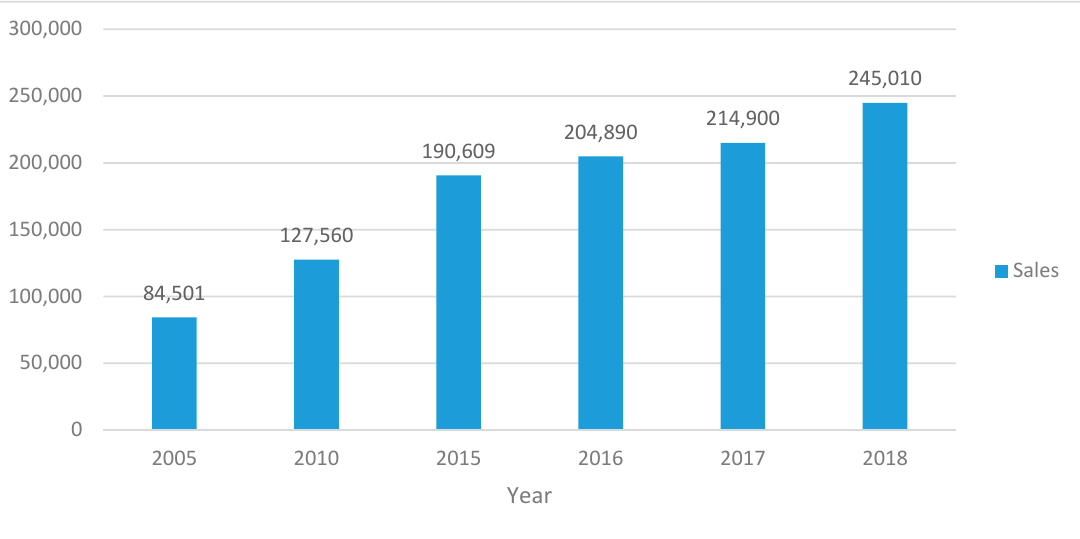
Figure 3. Sales of logistic, transport and storage services in Poland in the period 2005–2018 (PLN m). Source: Author’s own work based on GUS 2018.